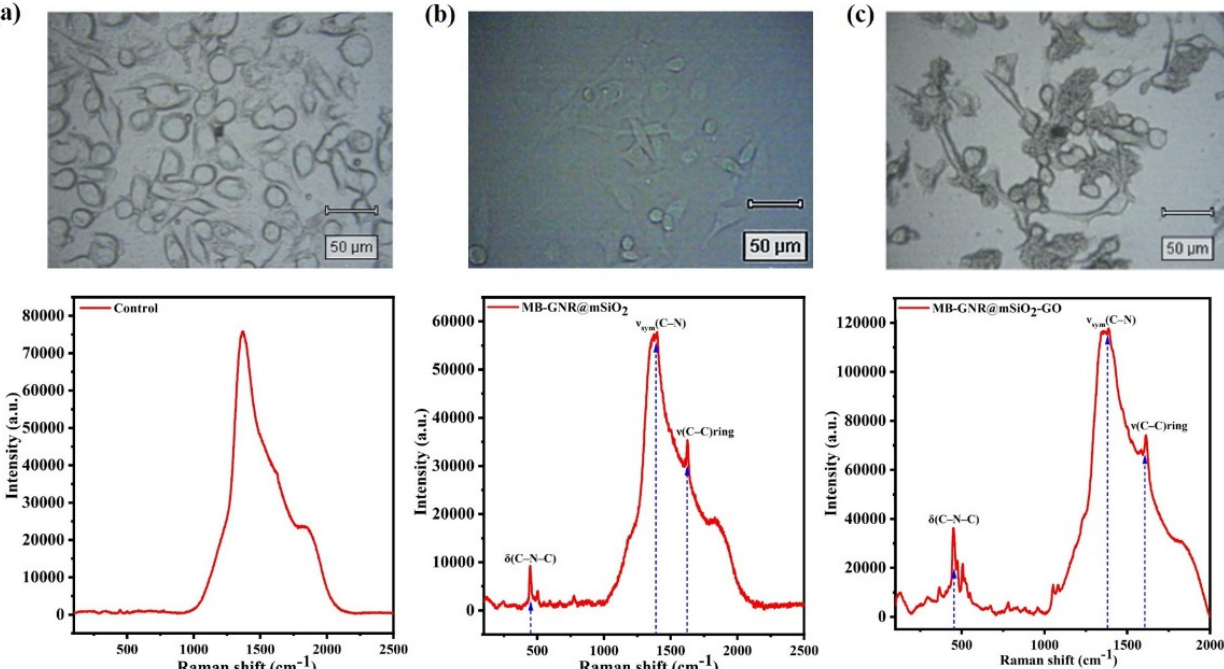
Figure 8. Bright-field images and micro-Raman spectra of MDA-MB-231 cells treated with control ( a ), methylene blue-loaded mesoporous silica-coated gold nanorods (MB-GNR@mSiO 2 ) ( b ), and methylene blue-loaded mesoporous silica-coated gold nanorods on graphene oxide (MB-GNR@mSiO 2 -GO) ( c ). The bright-field images indicate the laser-activated area ( λ = 785 nm, 2 mW, spot area = 2–100 µm).